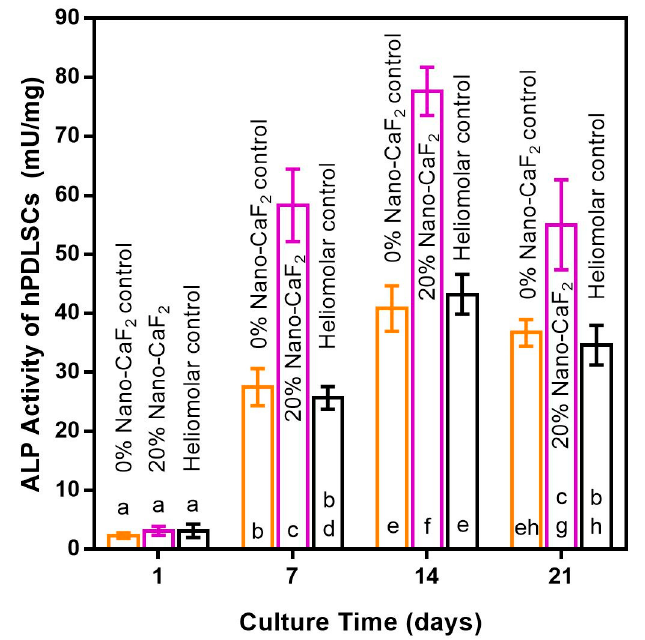
Figure 7. The ALP activity of hPDLSCs growing on composites. At 7, 14 and 21 days, the ALP activity of the 20% Nano-CaF 2 group was 57-fold, 78-fold and 55-fold those of 0% Nano-CaF 2 control at 1 day. Values with dissimilar letters such as a and b are significantly di ff erent ( p < 0.05, mean ± SD; n = 6).